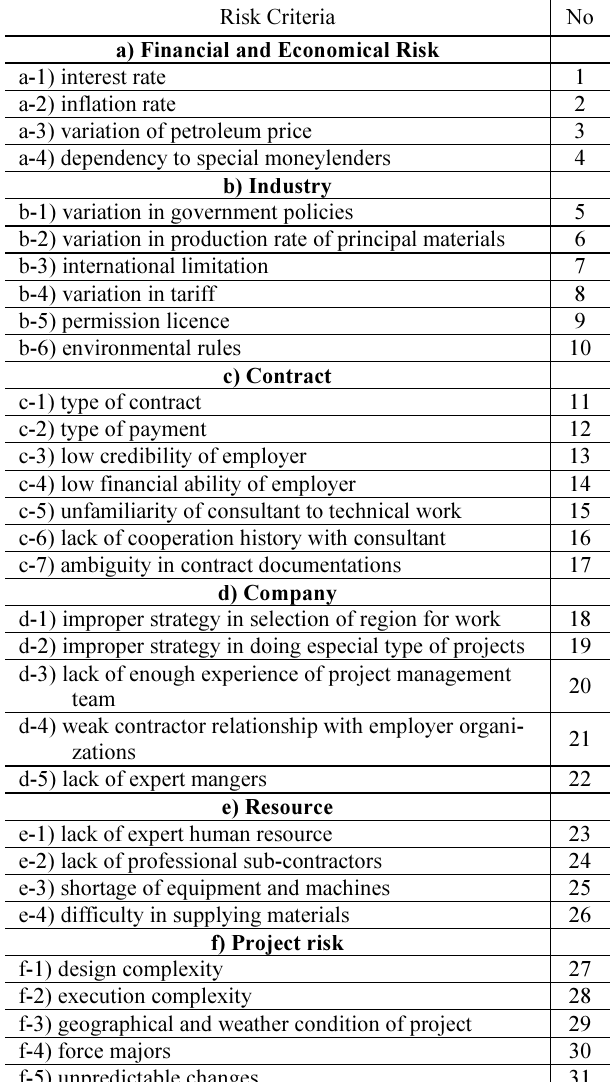
Table 3. Categorization and risk criteria Risk Criteria